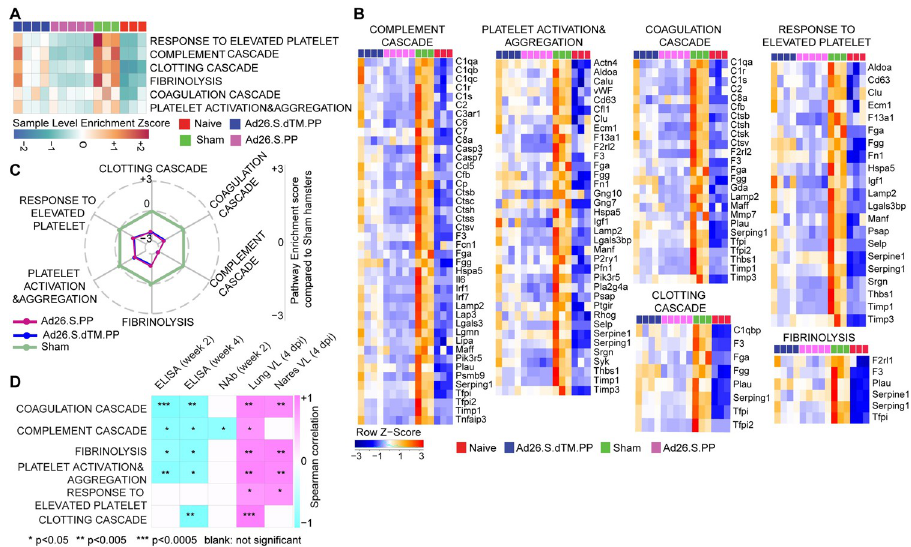
Fig 3. Ad26.COV2.S vaccination attenuates signatures of complement system activation and coagulation cascade associated with severe COVID-19. (A) Sample-enrichment analysis (SLEA) of pathways of thrombosis-associated pathways decreased in Ad26 vaccinated animals at 4 dpi (in pink and blue) compared to sham-unvaccinated animals (in green). Heatmap presenting the SLEA z-score of each of these pathways. SLEA scores represent the mean expression of all significant genes within each pathway for each animal. (B) Heatmaps of the normalized expression of the leading genes contributing to the enrichment of thrombosis-associated pathways increased by SARS-CoV-2 in sham animals (in green) and decreased in Ad26 vaccinated hamsters (in pink and blue) at 4 dpi. (C) Radar plot showing the GSEA normalized enrichment score (NES) of thrombosis-associated pathways decreased in Ad26 vaccinated hamsters in blue and pink compared to sham unvaccinated animals in green. (D) Correlation matrix plot showing the Spearman correlations of thrombosis-associated pathways at 4 dpi with viral loads in hamster’s lung and nares at 4 dpi and neutralizing and binding antibody titers at weeks 2–4 post-vaccination. Negative correlations were shown in cyan, and positive correlations were shown in pink.